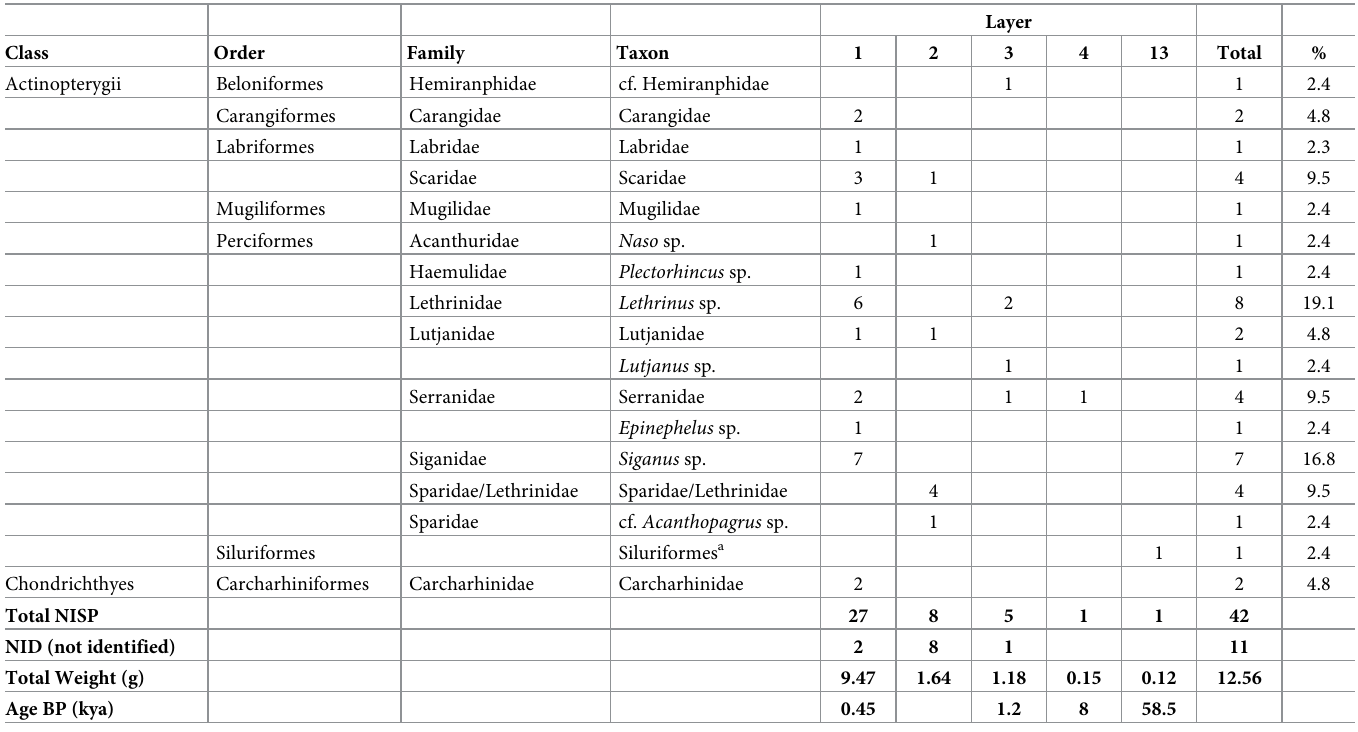
Table 3. PYS fish quantification (NISP) by